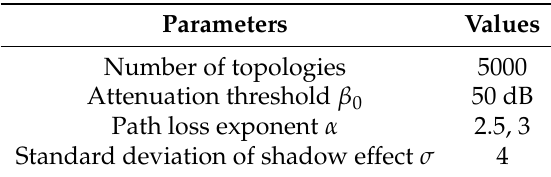
Table 9. Parameters in simulations of